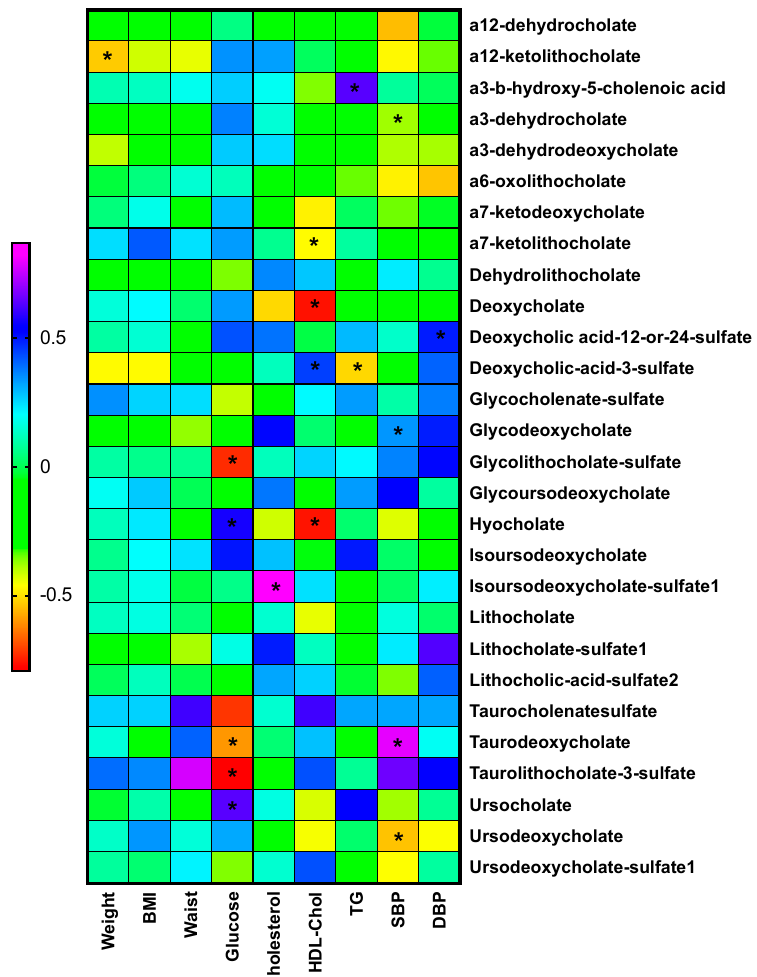
Figure 5. Heatmap of the Spearman correlations between changes in anthropometric and biochemical variables with the fold-changes in secondary bile acids. * Indicates p < 0.05.